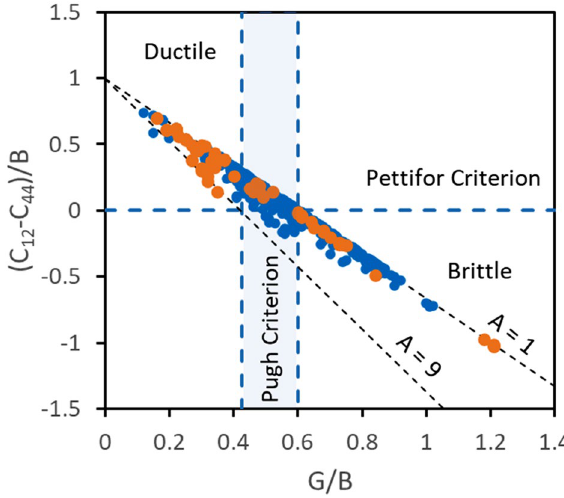
Figure 2. Correlation between C”/B = (C 12 –C 44 )/B and G/B for 308 compounds (blue points) and 24 metals (brown points) with cubic crystal structures analyzed in 5 . The linear trendlines are described by Eq. (6) for isotropic (A = 1) and highly anisotropic (A = 9) materials. The vertical band corresponds to G/B in the range of 0.42 to 0.6 to account for the effect of elastic anisotropy on the value of G at C 12 –C 44 =